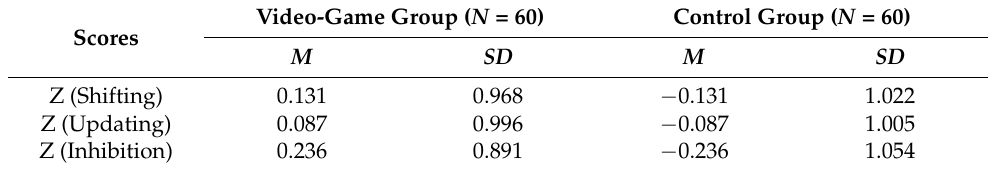
Table 3. Means and standard deviations for the Z-scores of the executive function components.